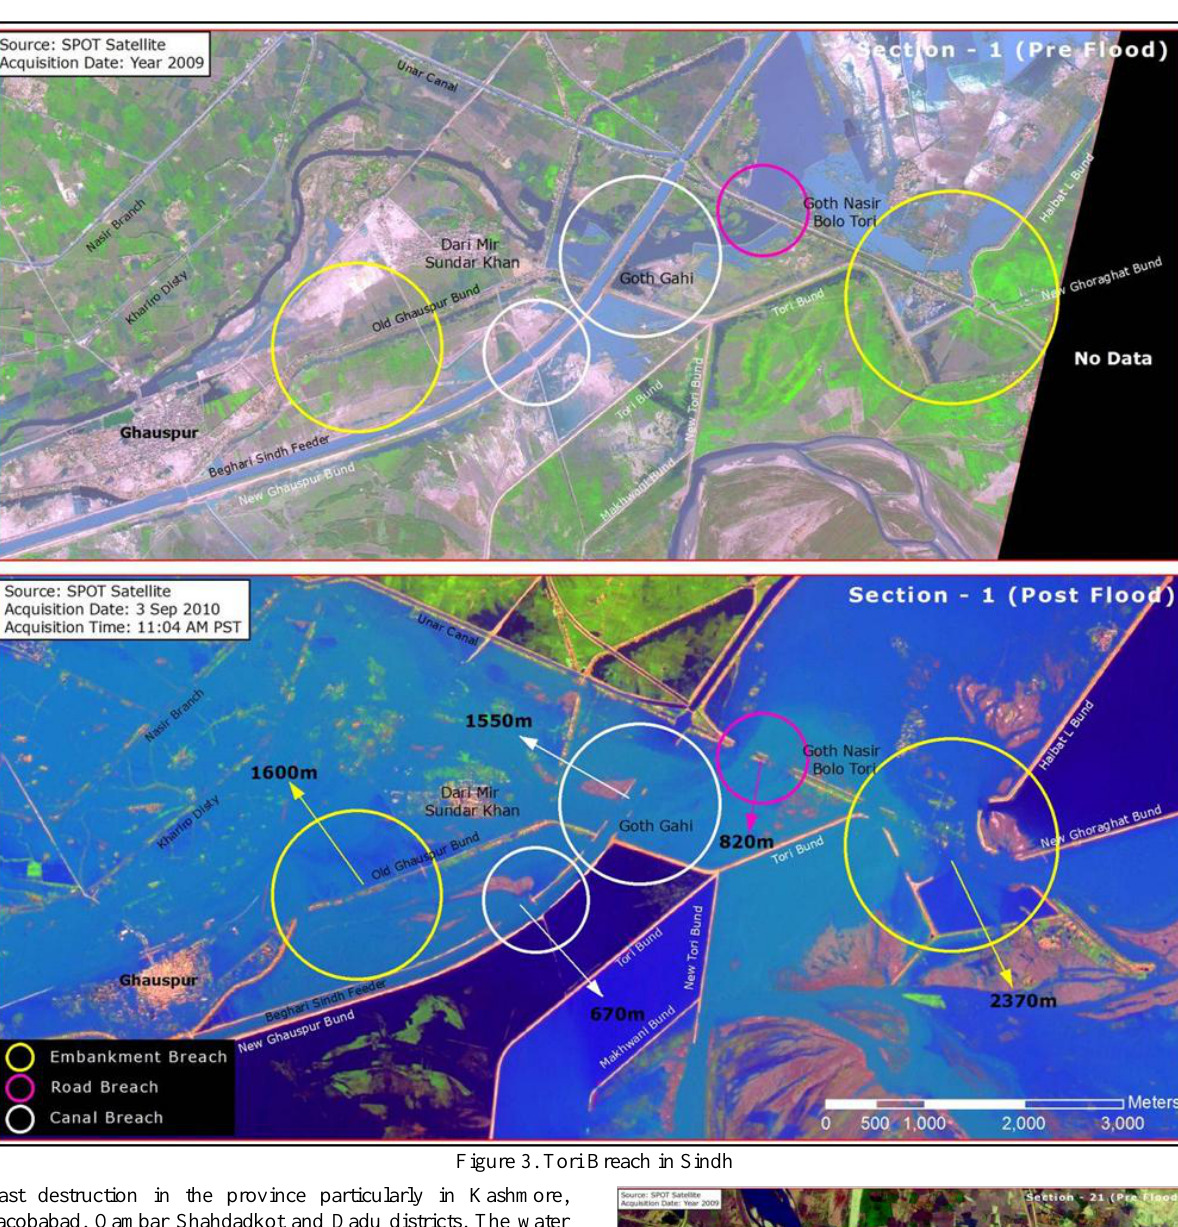
Figure 3. Tori Breach in Sindh